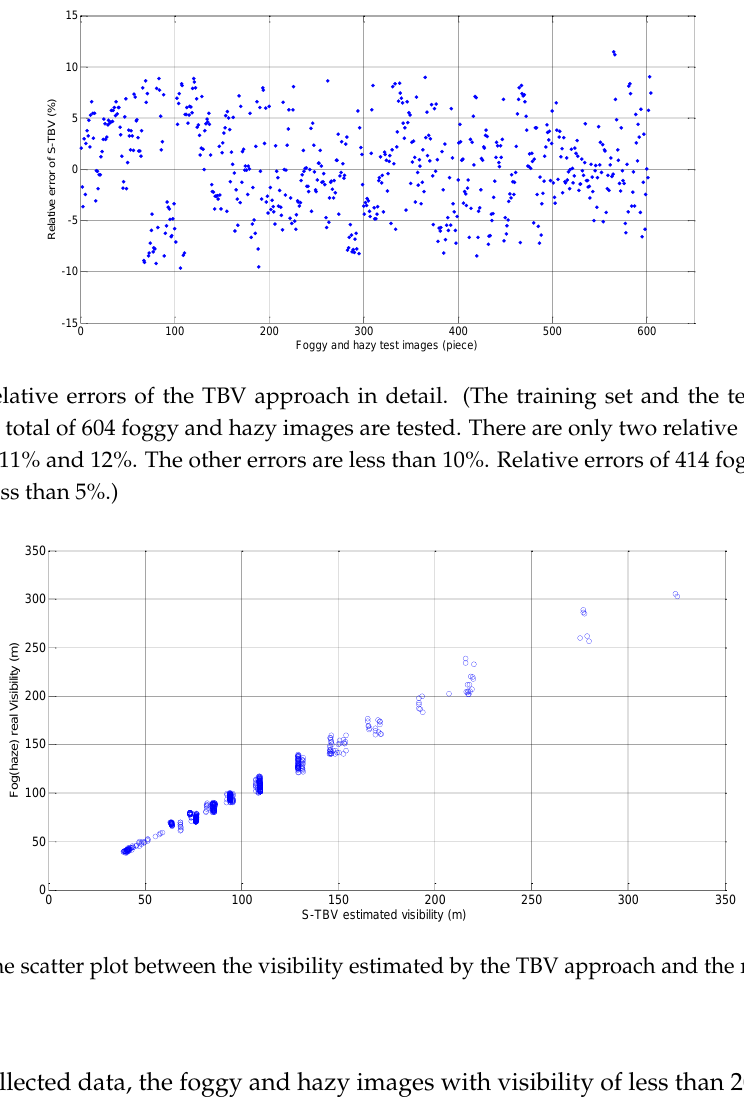
Figure 8. Relative errors comparison between the TBV approach and the image contrast model. (The image contrast model is based on [16] and the threshold 0.05 is used. The details about the relative error of the TBV approach are presented in Figure 9. The errors shown from in ( a – d ) are corresponding to the Points 2, 4, 5, and 6, respectively.)